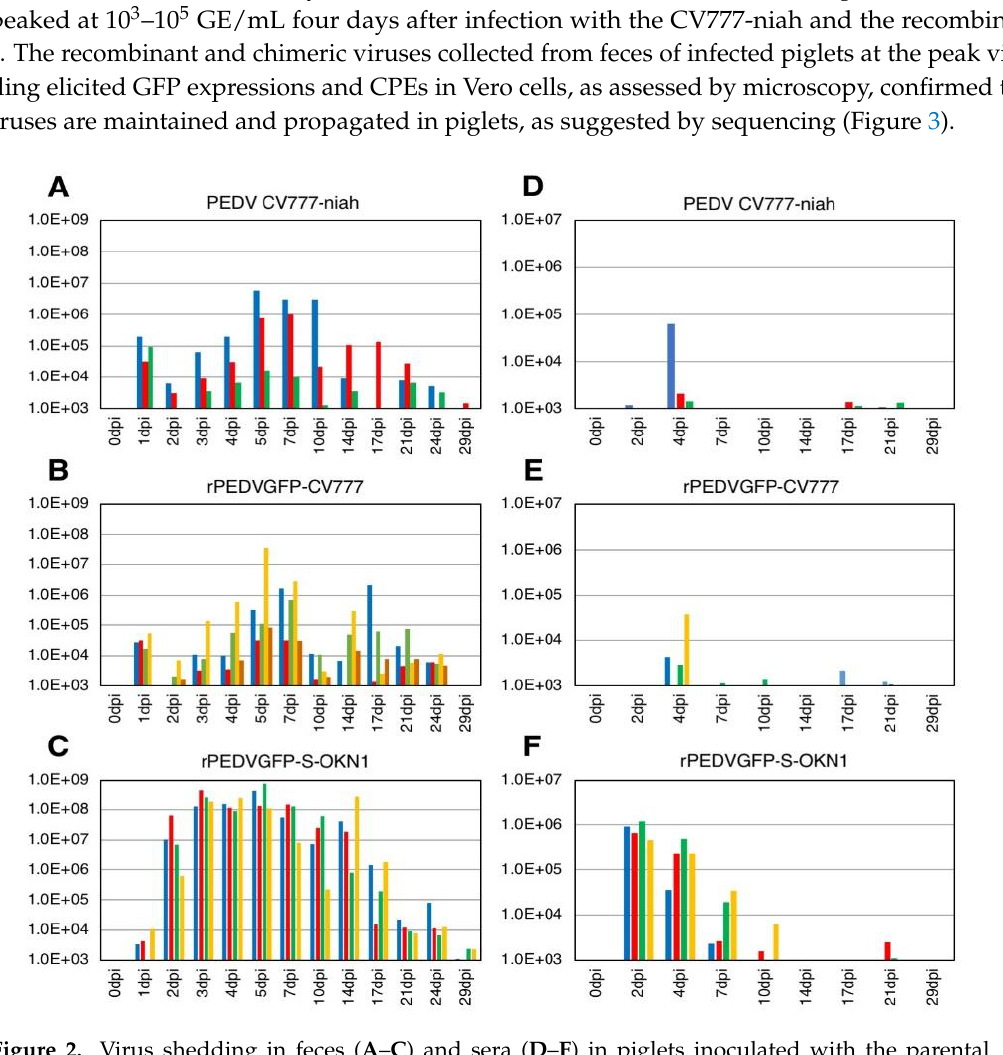
Figure 2. Virus shedding in feces ( A – C ) and sera ( D – F ) in piglets inoculated with the parental strain CV777-niah ( A , D ), its recombinant form, rPEDVGFP-CV777 ( B , E ), and the S-chimeric strain, rPEDVGFP-S-OKN1 ( C , F ). Data are genome equivalents/mL in individual animals indicated in different colors, as quantified at each time point by a real-time reverse-transcription quantitative PCR for the N gene.